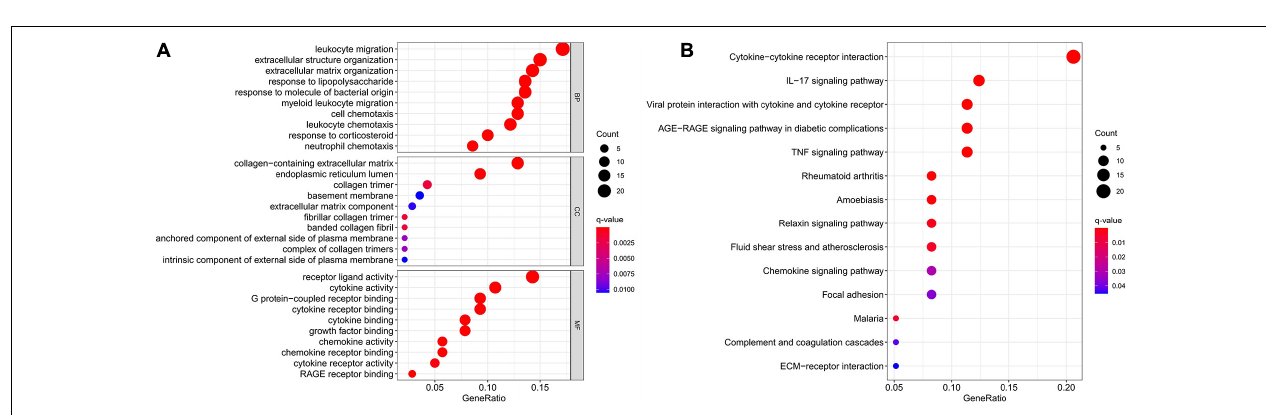
FIGURE 2 | GO and biological pathway enrichment analysis of DEmiRs. (A) Biological process for DEmiRs. (B) Cellular component for DEmiRs. (C) Molecular function for DEmiRs. (D) Biological pathway for DEmiRs. GO, Gene Ontology; DEmiRs, differentially expressed microRNAs. The asterisks represented the statistical q -values ( ∗ q -value < 0.05; ∗∗ q -value < 0.01; ∗∗∗ q -value < 0.001).